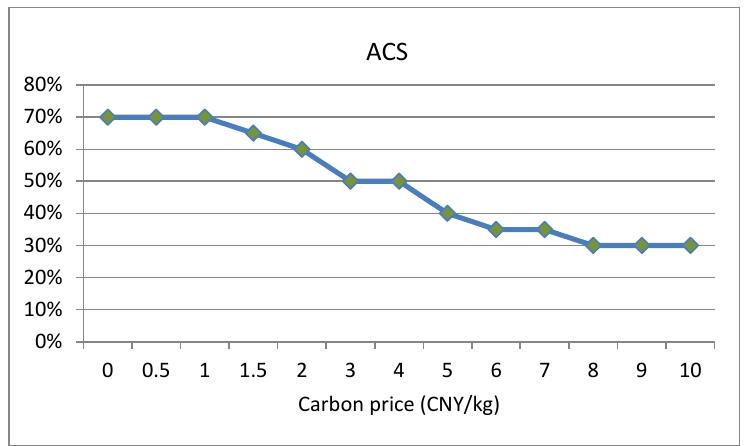
Figure 5. The changing trend of average customer satisfaction with the increase in carbon price under insufficient carbon quota.